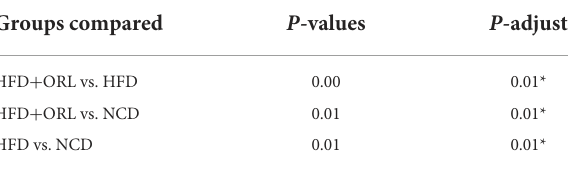
TABLE 1 PERMANOVA analysis of gut microbiota based on weighted Unifrac distance. Groups compared P -values P -adjust